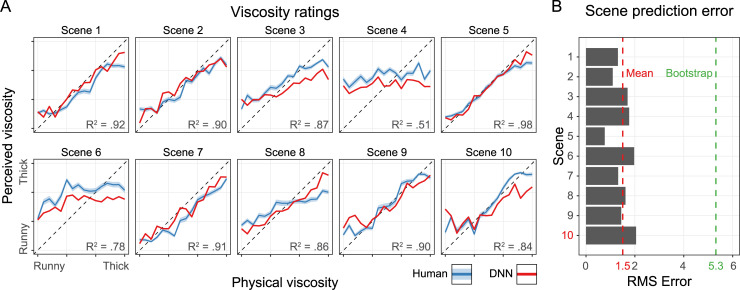
(A) Viscosity ratings for the 10 different scenes. The x-axis shows the physical viscosity steps (1–16). The y-axis shows the perceived/predicted viscosity averaged across the five variations. The error ribbons show the standard error of the mean (SEM). Blue lines are human viscosity ratings and red lines are DNN viscosity predictions. The dotted diagonal shows the physical truth. The DNN was not trained on any stimuli predicted here, and scene 10 (red) was completely left out of the training set in order to test generalization to other scenes. (B) The x-axis shows the Root Mean Square Error for each of the 10 scenes on the y-axis. This is the error between human observations and the network predictions. The red dotted line shows the mean error across scenes and the green dotted line the error of 1000 randomly drawn observations.